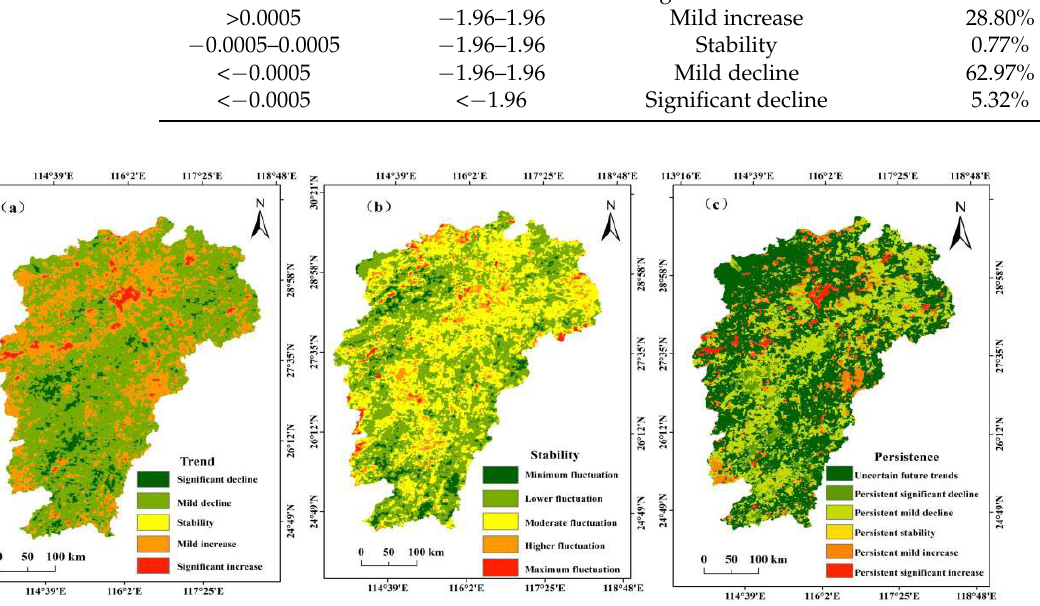
Figure-6. Distribution map of (a) LST trend, (b) stability, and (c) persistence characteristics in Jiangxi Figure 6. Distribution map of ( a ) LST trend, ( b ) stability, and ( c ) persistence characteristics in Jiangxi Province, China from 2000 to 2020. Province, China from 2000 to Table 4. Persistence classification of LST.